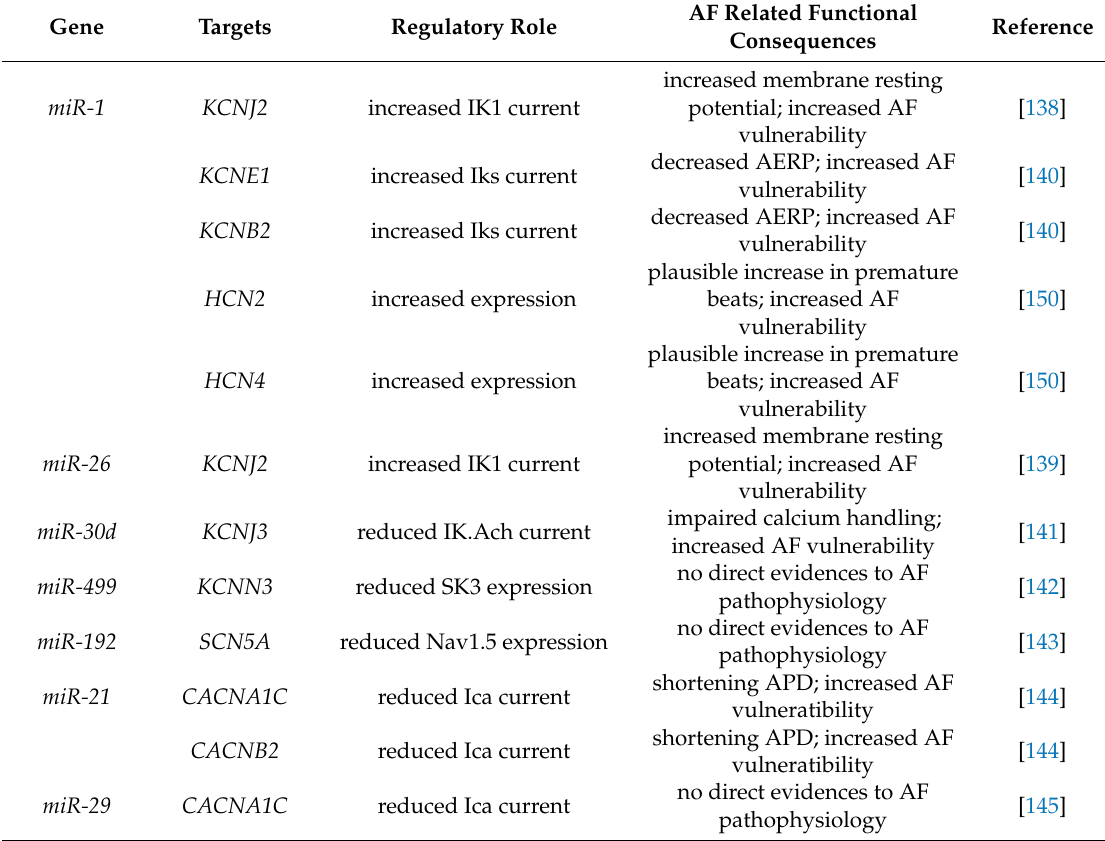
Table 3. AF associated microRNAs and their functional consequences in AF electrophysiology.